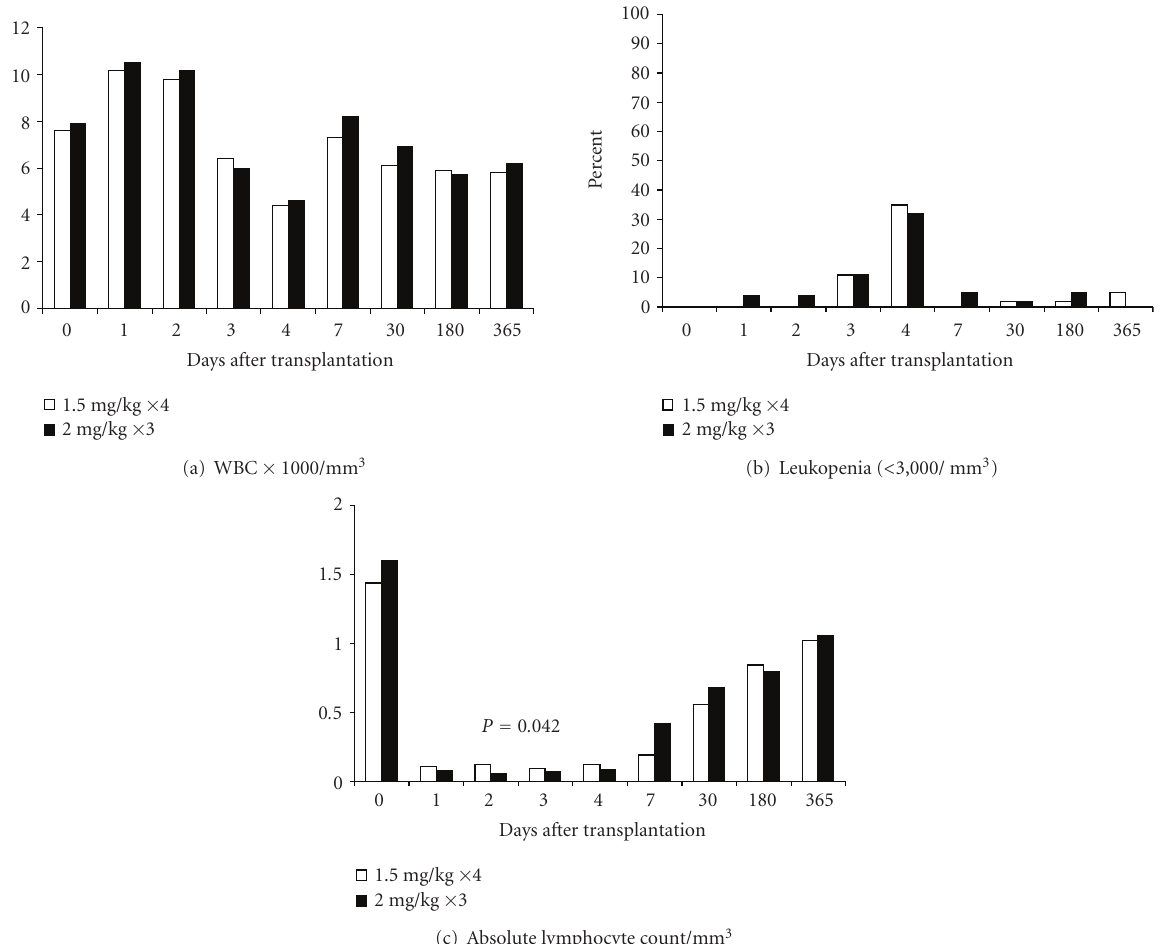
Figure 2: Figures 2(a), 2(b), and 2(c). White blood cell counts and incidence of leucopenia. White blood cell counts and the percentage of patients with leucopenia were similar in both groups throughout one year after transplantation. The absolute lymphocyte count was statistically lower in the 2mg/kg arm on postoperative day 2 ( P = . 42) but similar throughout the rest of the study period.